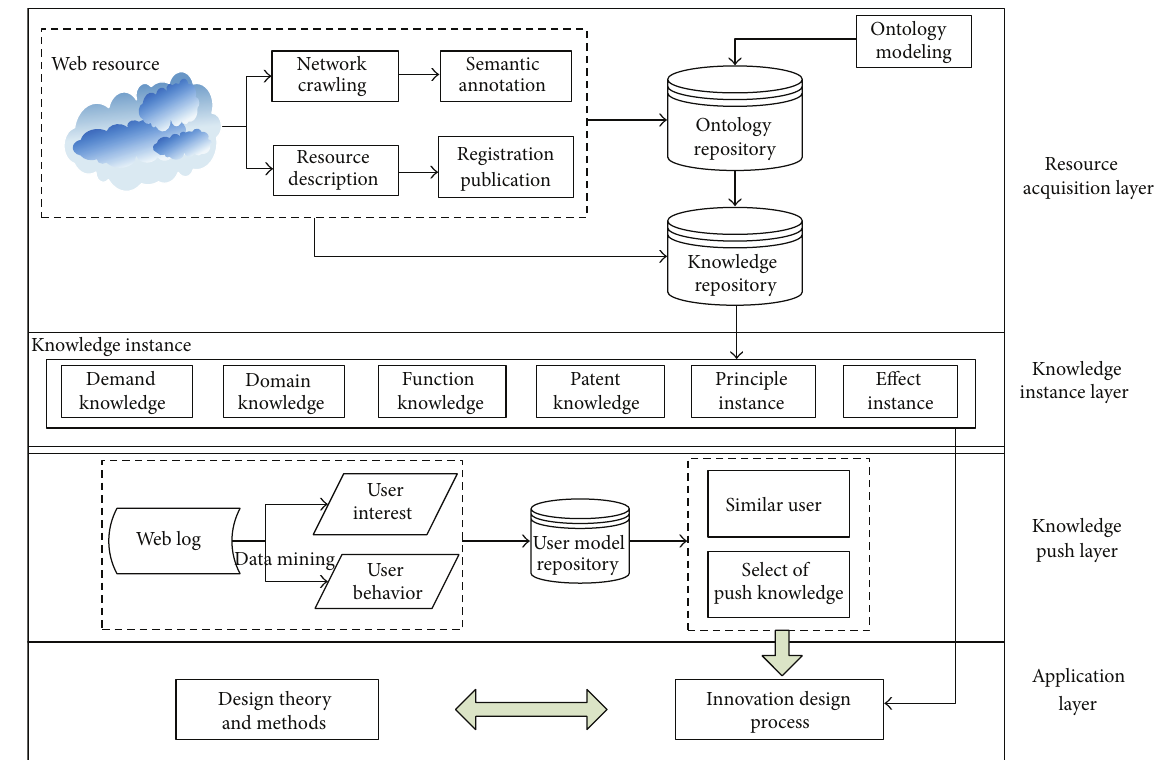
Figure 2: Knowledge resources network integration